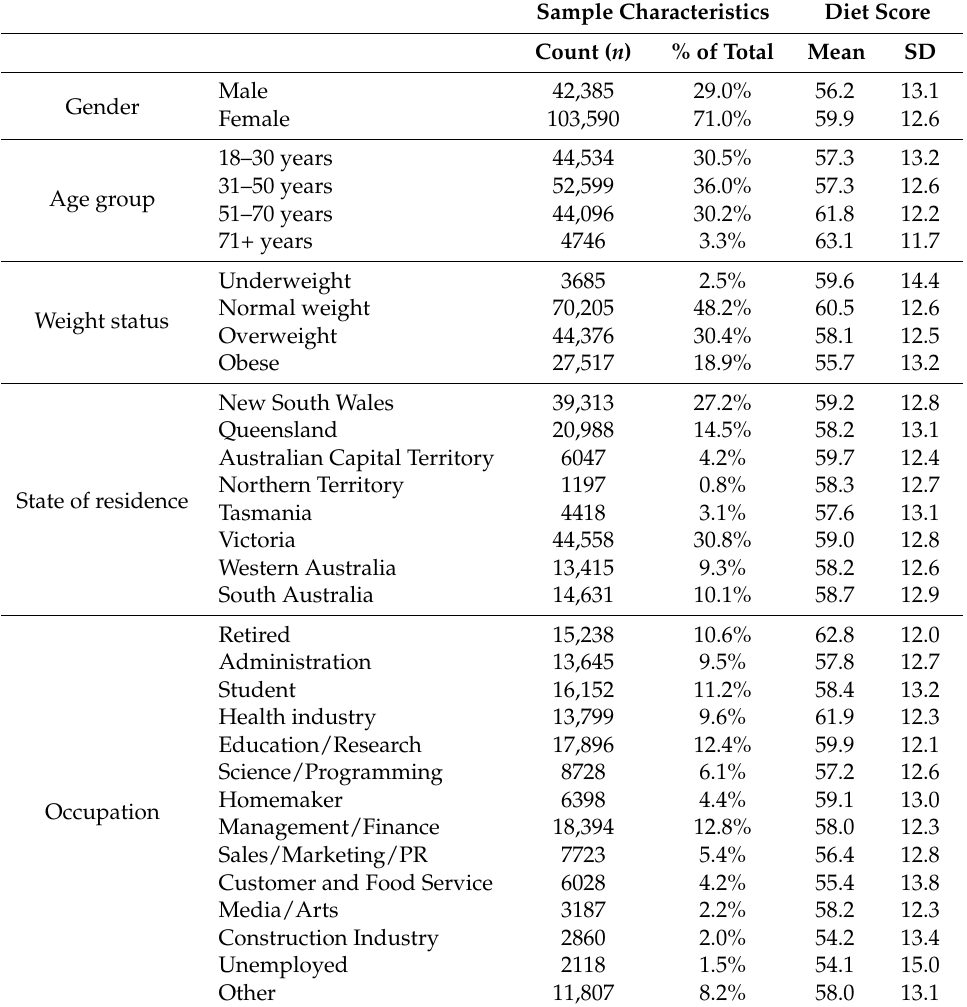
Table 1. Characteristics of the CSIRO Healthy Diet Score Survey Sample and Summary Diet Scores by Demographic Characteristic ( n = 145,975).